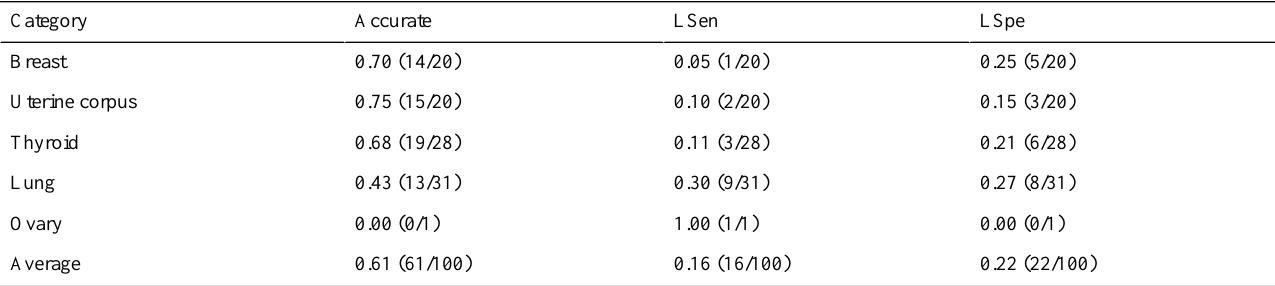
Table 4. Accuracy of diagnosis based on sWSI VS by pathologist A. Results are presented as ratios between 0.00 and 1.00. LSpeLSenAccurateCategory